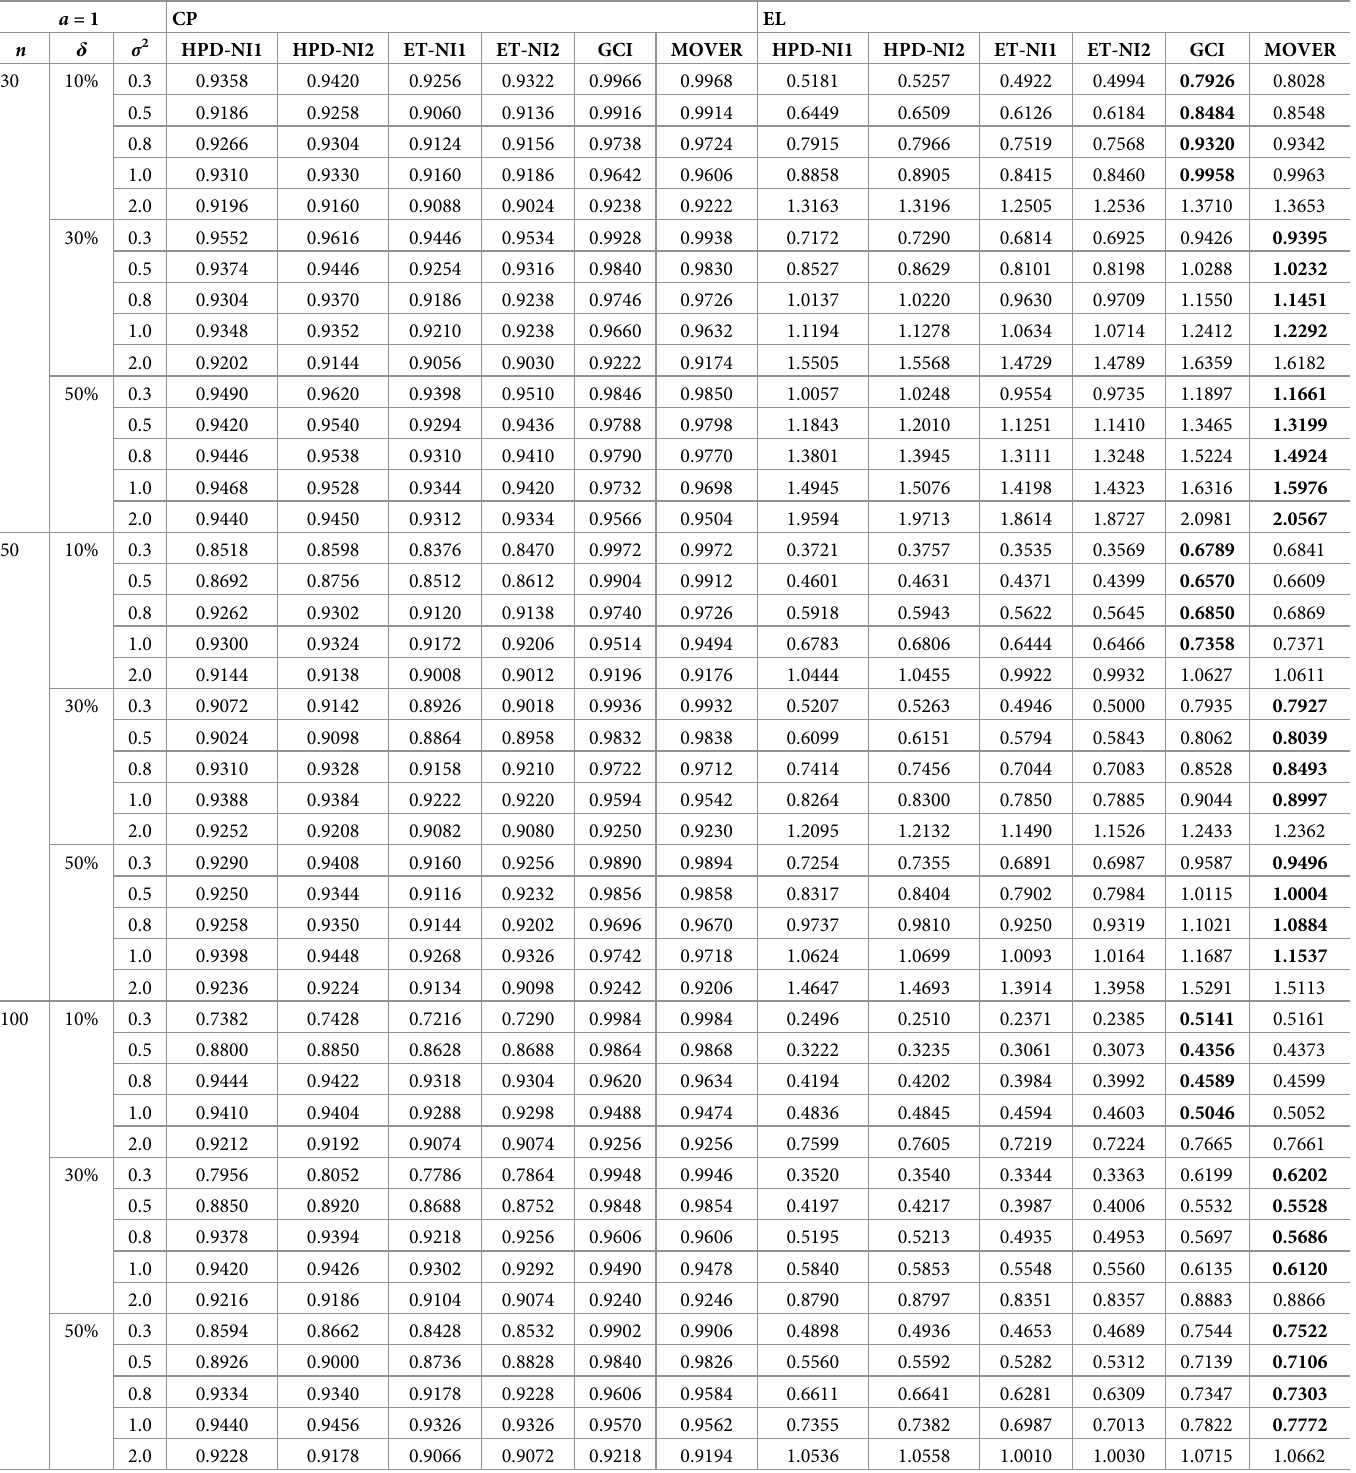
Table 1. CP and EL performances of 95% CI for θ : a =